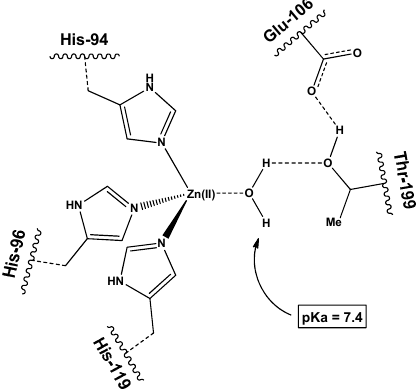
Figure 1. Zn-bound water and nonbonded interactions of Thr-199 and Glu-106 residues.